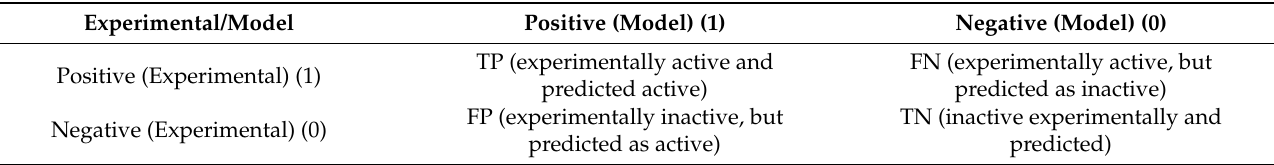
Table 5. Elements of the confusion matrix that show the possible outcomes when predicting labels in Tox21. Experimental/Model Positive (Model) (1) Negative (Model) (0) TP (experimentally active and FN (experimentally active, but Positive (Experimental) (1) predicted active) predicted as inactive) FP (experimentally inactive, but TN (inactive experimentally and Negative (Experimental) (0) predicted as active)